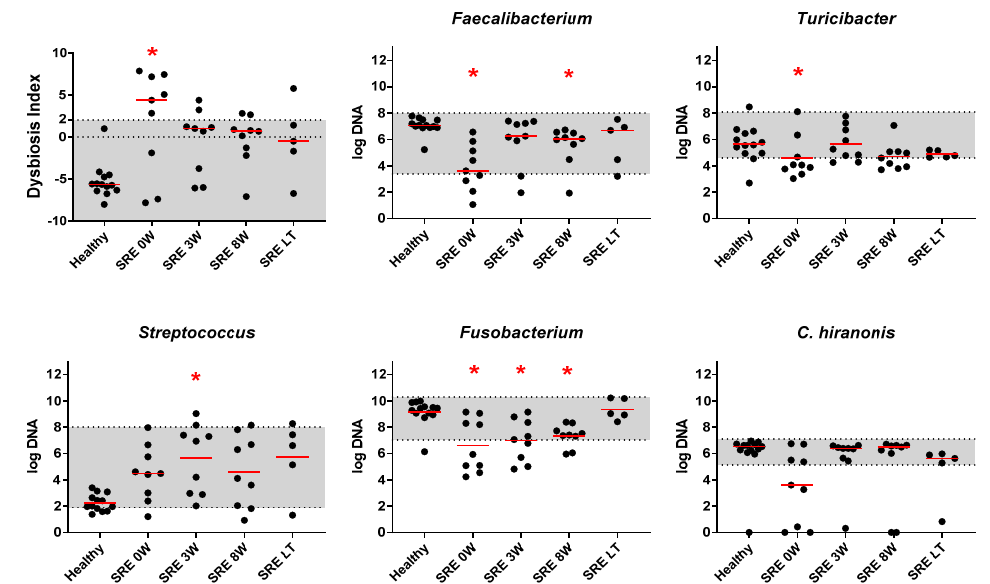
Figure 3. Fecal Dysbiosis Index (DI) and results of qPCR for selected keystone species. Grey shaded areas represent the reference intervals for DI and individual taxa. Red asterisks indicate statistical significance ( p < 0.05) in comparison to healthy controls, calculated through Kruskal-Wallis test followed by Dunn’s multiple comparisons test. Red lines indicate median.